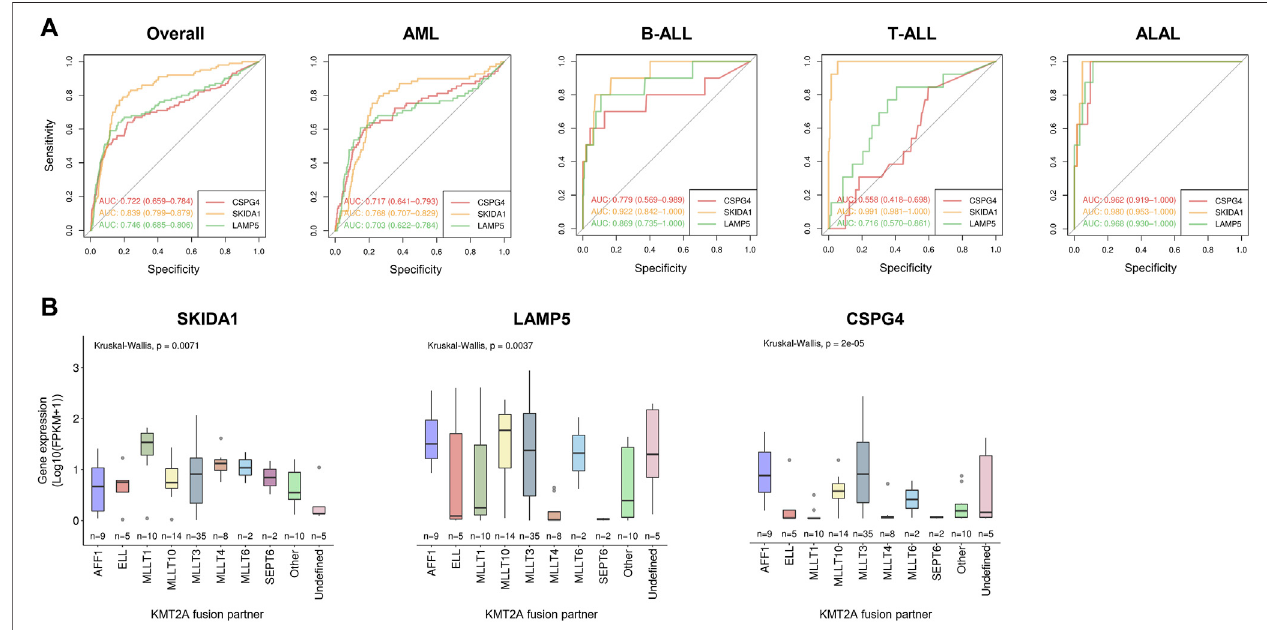
FIGURE 3 | Relationship between SKIDA1 , LAMP5, and CSPG4 expression and KMT2A -r in acute leukemia. (A) ROC curves and AUC values of each gene transcript according to acute leukemia subtypes. (B) Transcript expression among varied KMT2A fusions.